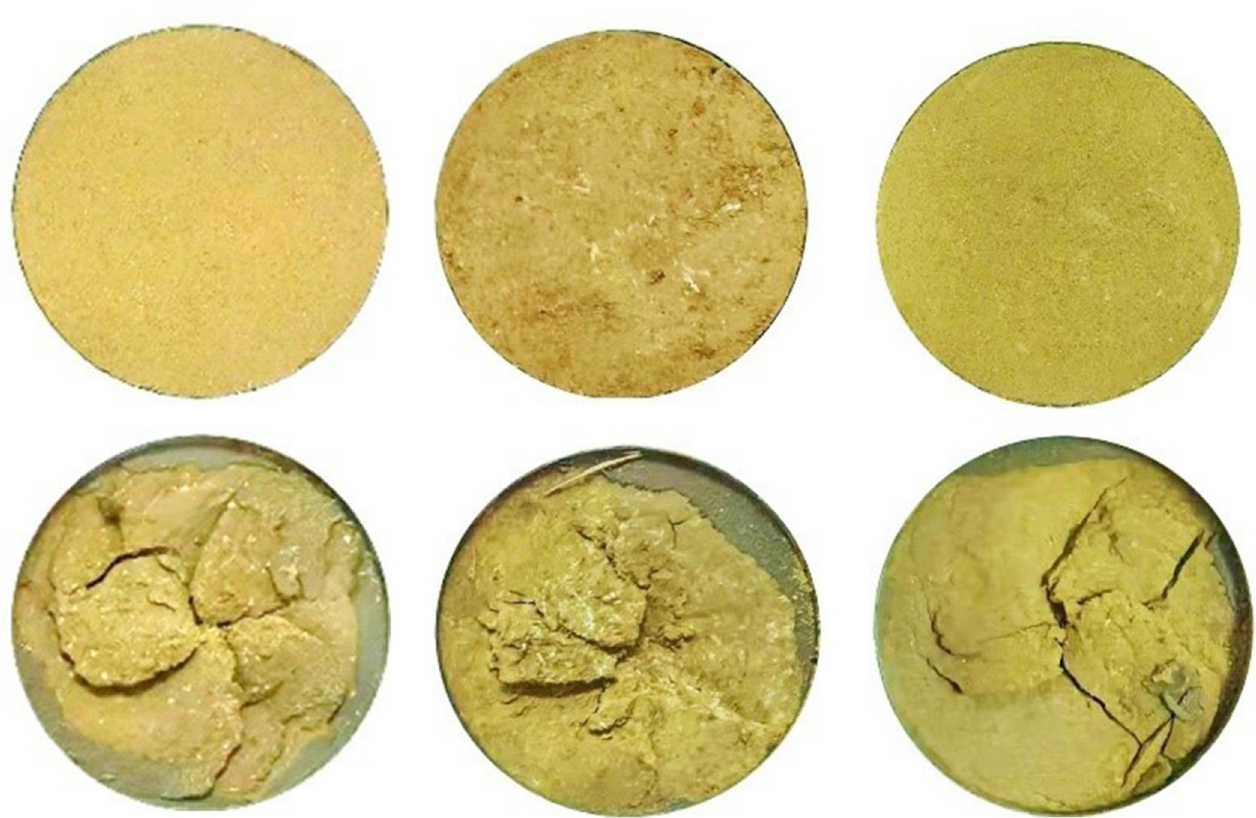
Fig 10. Comparison of the shear surface morphology of 22 # - 24 # remolded loess specimen before and after the test. (A ) 22 # w = 16%. (B) 23 # w = 19%. (C) 24 # w =